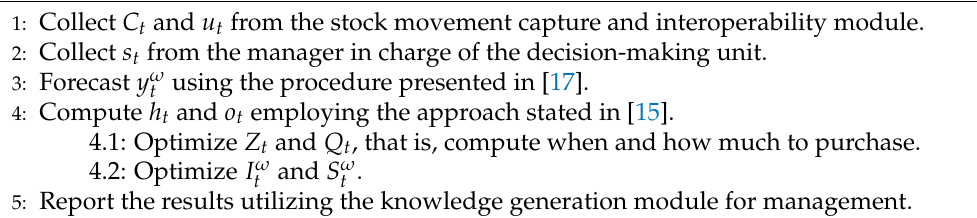
Algorithm 1 Steps of the stochastic programming